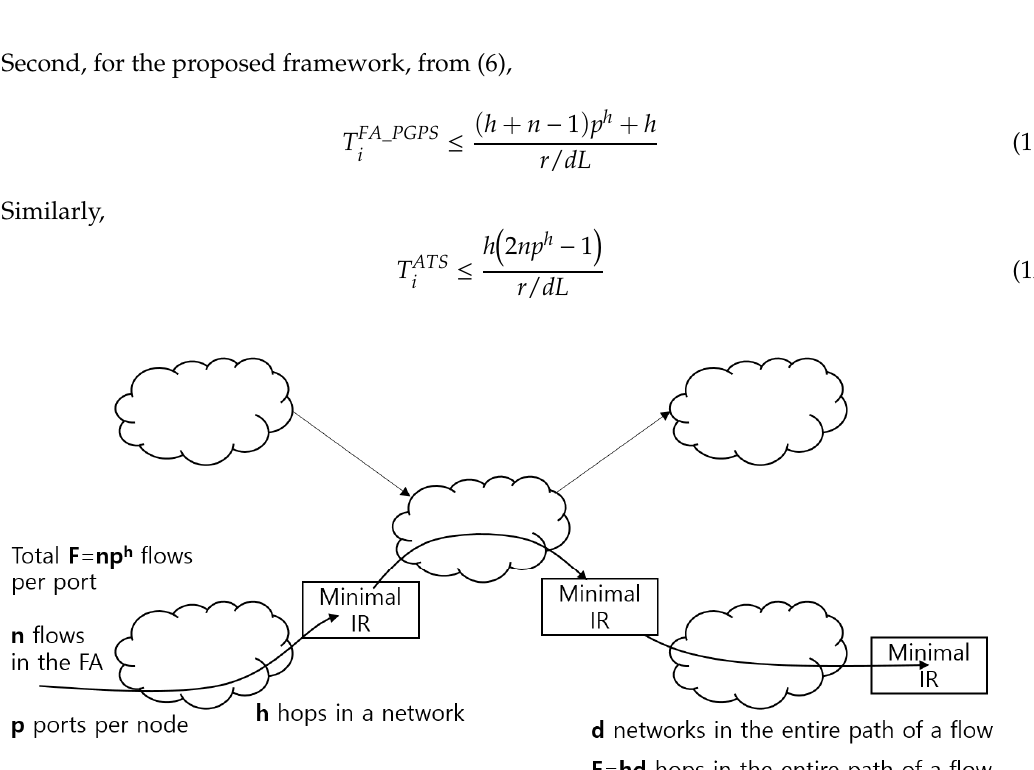
Figure 6. Architecture of the entire network, with d networks in the path of the flow under observation.